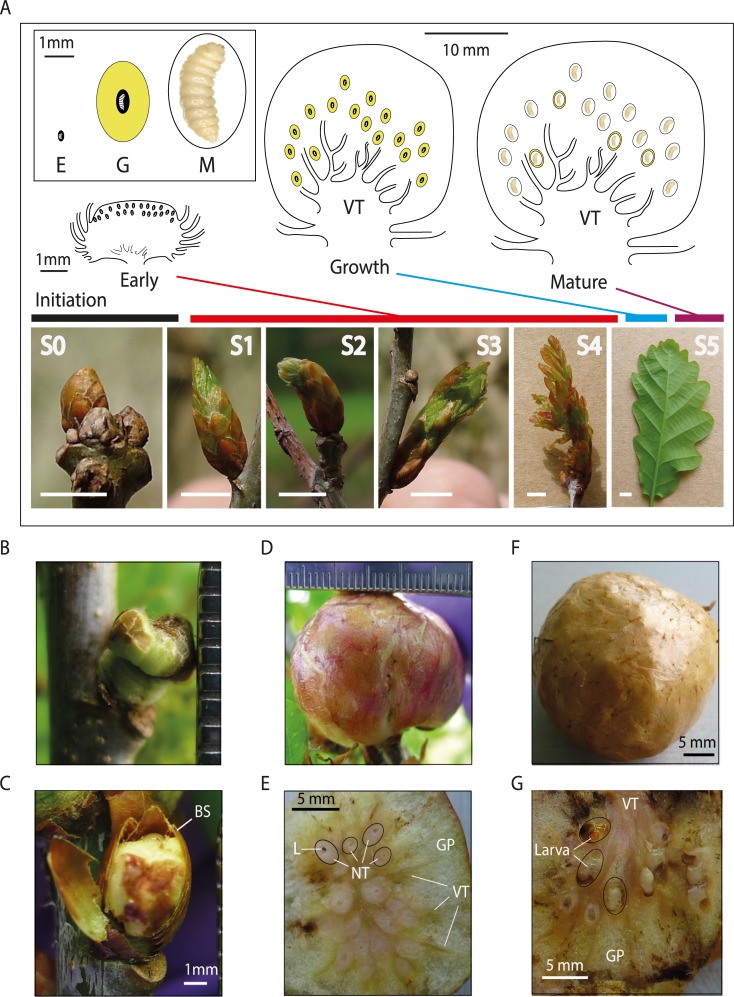
Stages in the development of the sexual generation galls of Biorhiza pallida and of ungalled buds of Quercus robur.A: Diagrammatic sections of Early, Growth and Mature stage galls, and their developmental phenology relative to recognised stages in the development of normal buds. Full gall development takes between 3 and 6 weeks. The inset shows the relative sizes of the larval chambers, larvae and nutritive tissues in each gall stage, with nutritive tissues shaded in yellow, fluid filled space in black, and an air space in white. Normal bud development in Quercus robur is shown for sampled examples of six widely recognised developmental stages: S0—Buds appear dormant with no bud-burst activity; S1—buds have the first visible swelling of bud-burst; S2—buds have started to grow as indicated by increased bud length and diameter; S3—distinct leaves are now visible; S4—leaf and stem development has begun; S5 leaves are now mature, and the associated stem has begun to elongate. Scale bars in panels S0-S5 are 5mm. B-G: Whole galls (B,C,D,F) and sections (E,G) of galls of each stage sampled in this study. B, C: Early stage galls are less than 5 mm in diameter, and are commonly partially concealed by bud scales (BS; removed in B, partially removed in C). The gall contains multiple larval chambers, each containing a single gall wasp larva. At this stage, the gall wasp larvae are ca. 0.25 mm long. D, E: Growth stage galls are 20–40 mm in diameter, with clearly differentiated tissues in section. The red epidermis is characteristic of these galls on exposure to sunlight. The sectioned gall (E) shows the spongy gall parenchyma (GP) developing around the larval chambers, four of which have been outlined in black. Each larval chamber at this stage contains nutritive tissues (NT) surrounding a larva 0.25–1.0 mm long (an example is outlined in black, and labelled L). Vascular tissues (VT) can be seen radiating through the gall from the central point of connection with the oak shoot. F, G: Mature stage galls have a brown and papery epidermis. The sectioned gall (G) shows large feeding larvae within their fully developed chambers, with pronounced lignification of surrounding tissues. In the upper outlined chamber all of the nutritive tissues have been consumed, and the head capsule of the mature larva is visible.